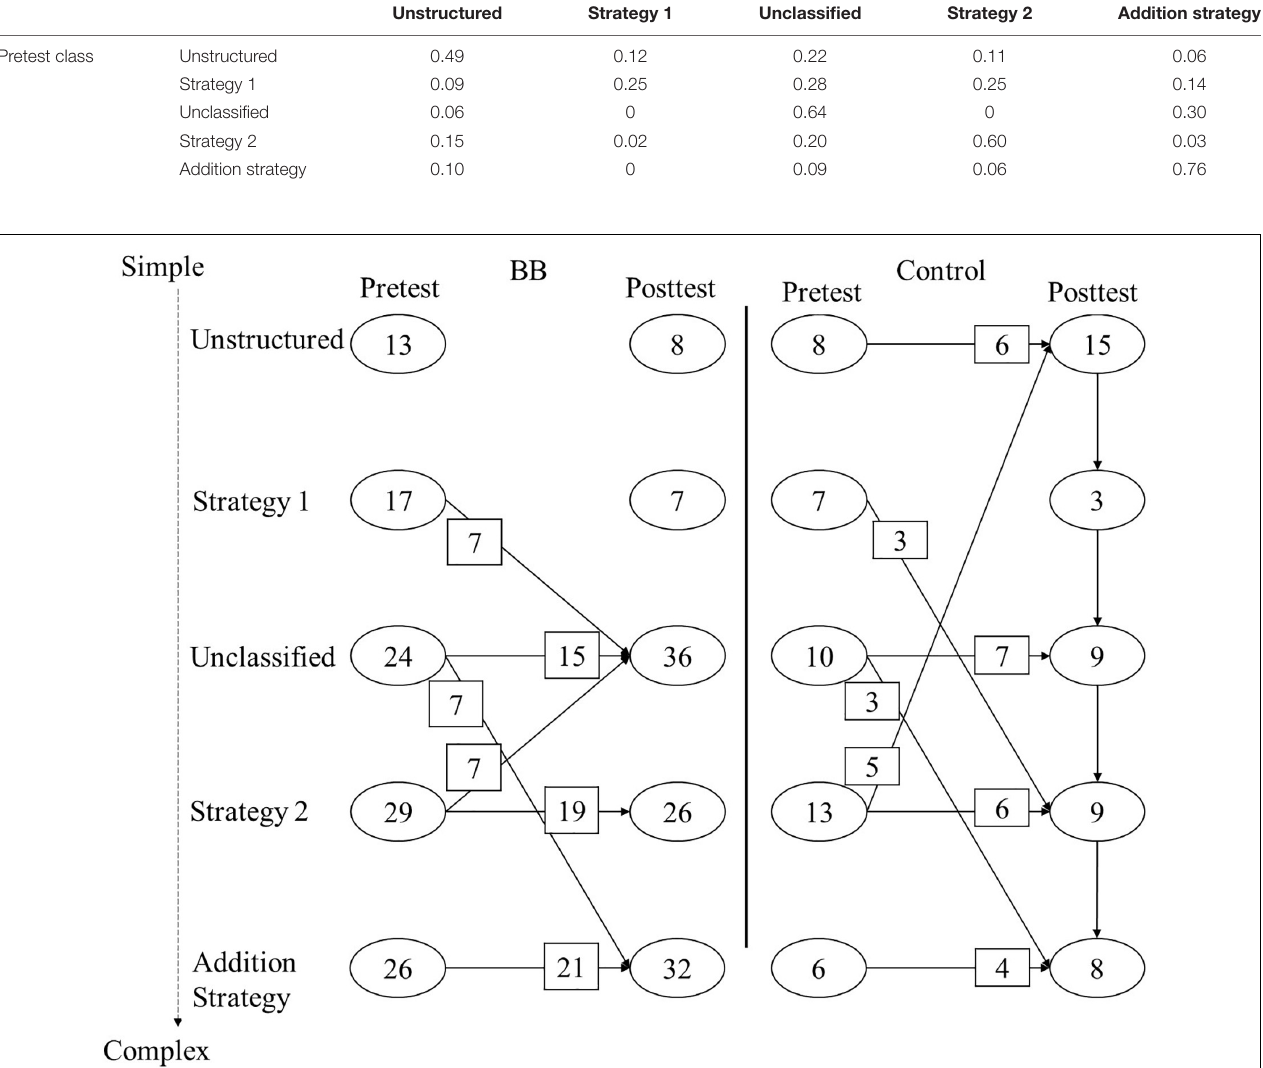
FIGURE 4 | Number of children per class for pretest and posttest with the transitions for the control and balance beam (BB) conditions. Transitions smaller than 5% of the sample were omitted from the figure for parsimony; see Appendix B for all